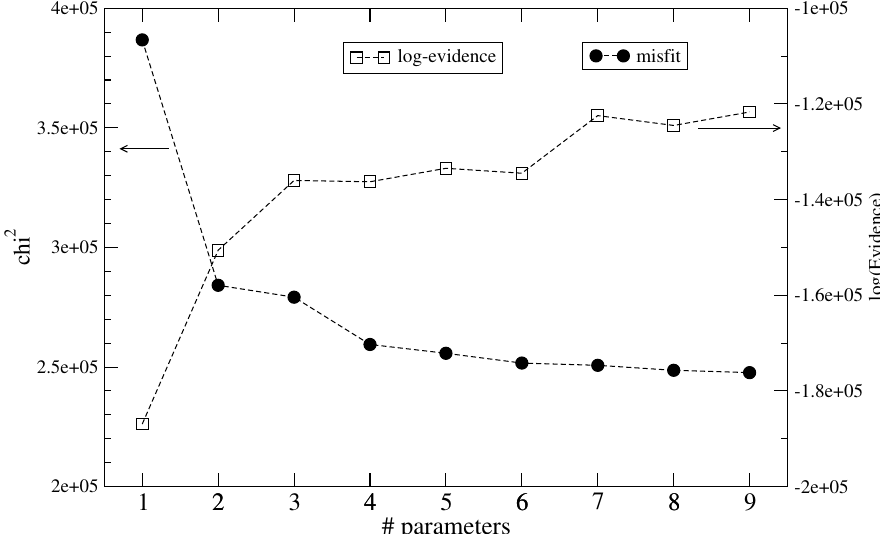
Figure 6. Misfit and evidence as function of the number of parameters. For each number of parameters the corresponding best fit is provided. On the left hand ordinate the misfit ( χ 2 -value) between data and model is given. On the ordinate on the right hand side the logarithm of the model evidence is given. Higher values indicate a more probable model. As can be clearly seen from both misfit and model evidence the commonly used 1 parameter regression is inadequate. The evidence obtains nearly identical peak value maxima for 7 and 9 parameters where also the improvement for the χ 2 -values levels